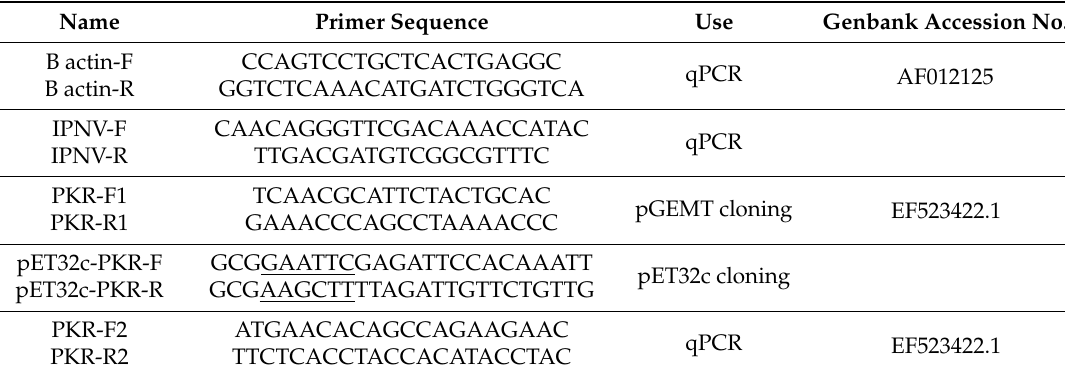
Table 1. Primers used for